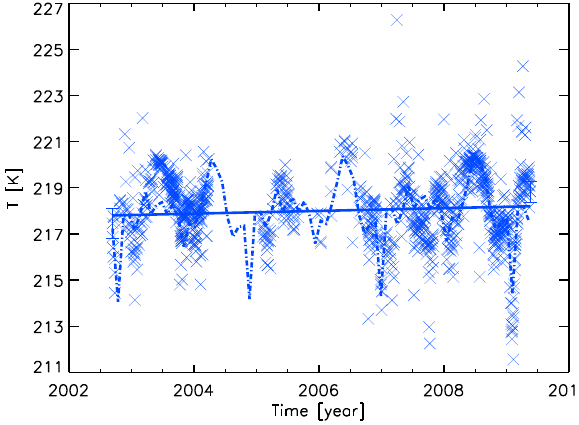
Fig. 4. Linear trends from MIPAS daily mean temperatures at 25km altitude, 30 ◦ S–30 ◦ N, using the continuous empirical peri- odical correction, as described in Sect. 3.3. Both the linear part of the regression function (solid line) and the complete regression function (dash dot) are